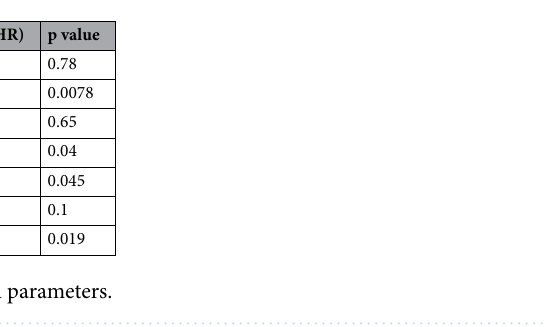
Figure 5. ROC curves of two clusters show high AUC the candidate genes. The ROC curves of all genes in each cluster are shown.